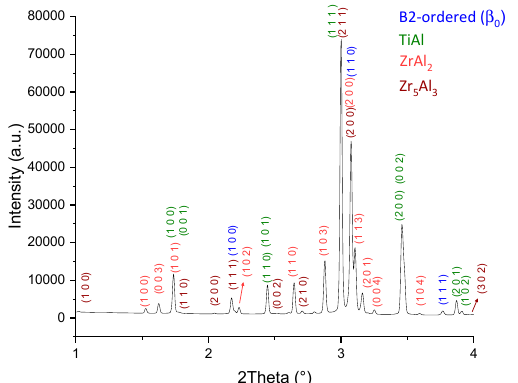
Figure 2. HE-XRD analysis of Z4 (Ti-44.7Al-16.5Zr at. %) heat treated at 1000 °C/100 h.